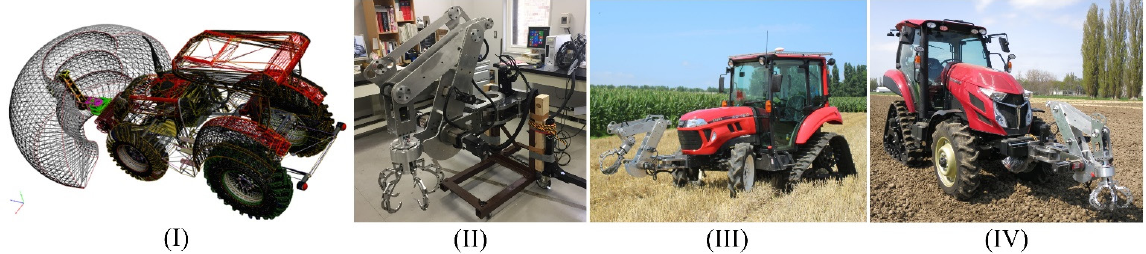
Figure 2. Development stages: (I) design, (II) adjustments and evaluation, (III) implementation, (IV) installation/operation.